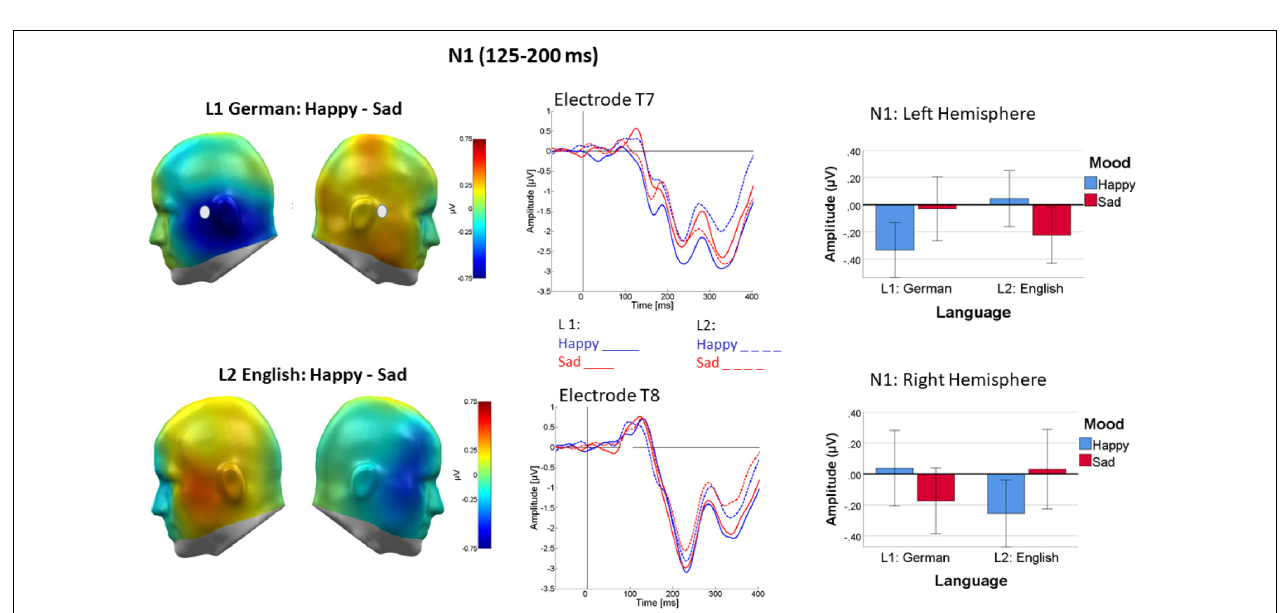
FIGURE 5 | Difference topography of word processing following happy minus sad mood induction in L1 (top left) and L2 (bottom left) in the N1 time window (125–200 ms). Middle panel : ERP at representative sensors T7 (top row) and T8 (bottom row) , revealing stronger mood-dependent lateralization in happy mood in L1 than L2. Right panel shows the pattern as bar charts separately for the left and right temporal sensor groups and L1 (German) on the left and L2 (English). Error bars are standard errors.